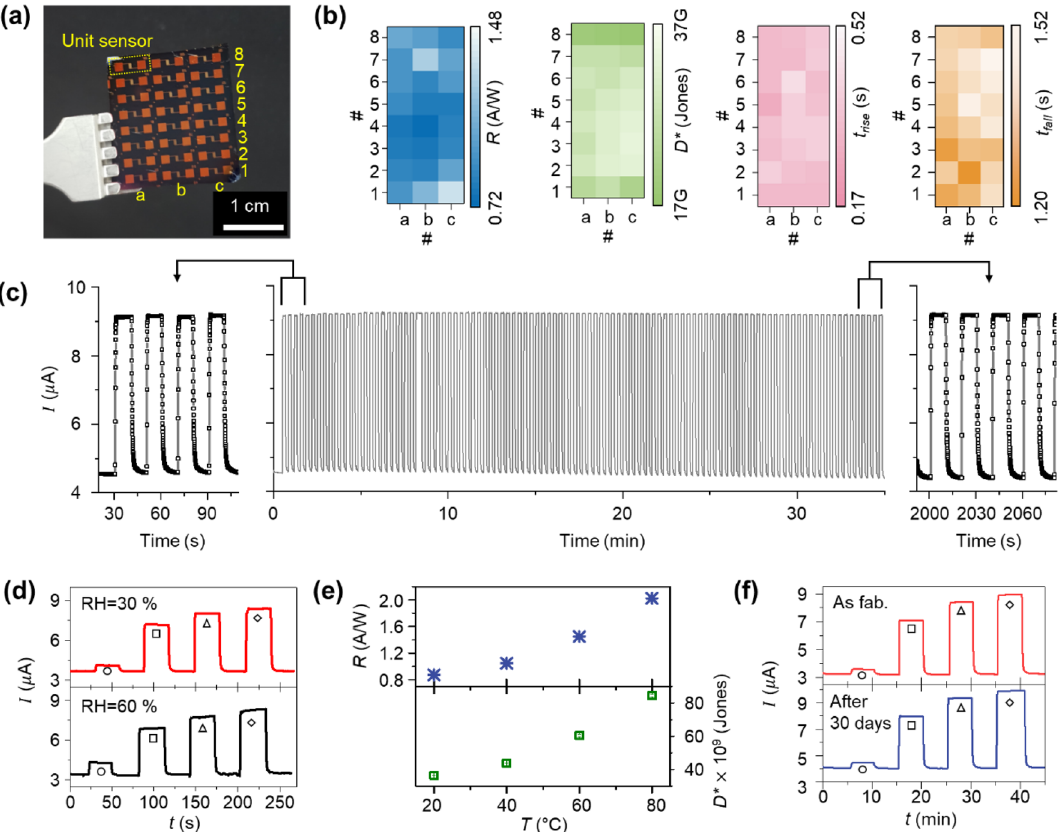
Figure 5. ( a ) Optical image of the fabricated 24-unit device array. ( b ) Photo-responsivity ( R ), photo-detectivity ( D * ), and rise ( τ r ) and decay ( τ d ) time of the fabricated device array. ( c ) 100-times repetitive illumination test with P light = 2.92 mW/cm 2 . Performance stability of the device within various environmental conditions. ( d – f ) Stability of the fabricated device. Optoelectronic characteristics in different humidity conditions ( d ), and R , D * changes of the device with respect to external temperature ( e ). Optoelectronic characteristic changes after 30 days ( f